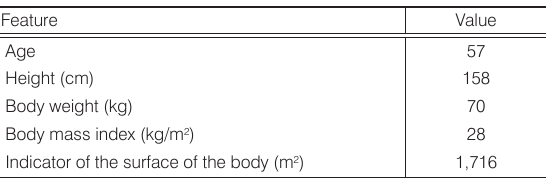
Table 1. Anthropometric data.